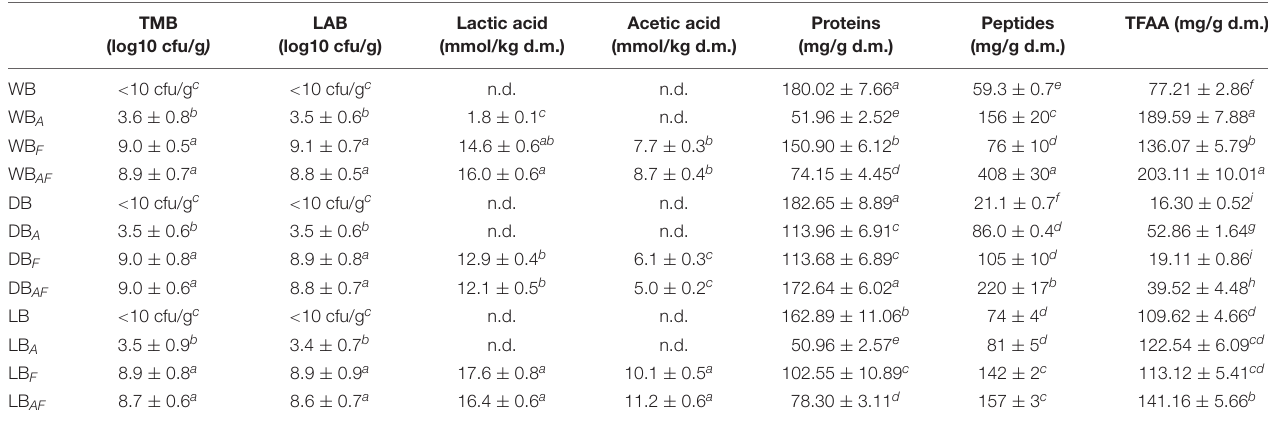
TABLE 1 | Microbiological and biochemical characteristics of wet (WB), dried at low temperature (DB), and lyophilized (LB) Spirulina biomass. TMB LAB Lactic acid Acetic acid (log10 cfu/g ) (log10 cfu/g) (mmol/kg d.m.) (mmol/kg